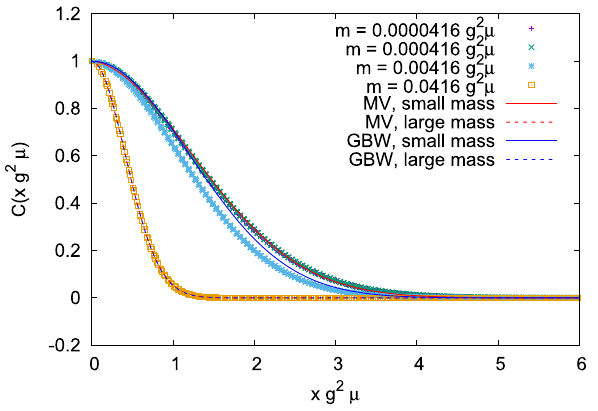
Fig. 3 Dipole amplitude generated from the discretized MV model on the torus with an infrared regulator in a large volume g 2 μ L = 983 . 04. Calculation done using a linear extend of L / a = 16384